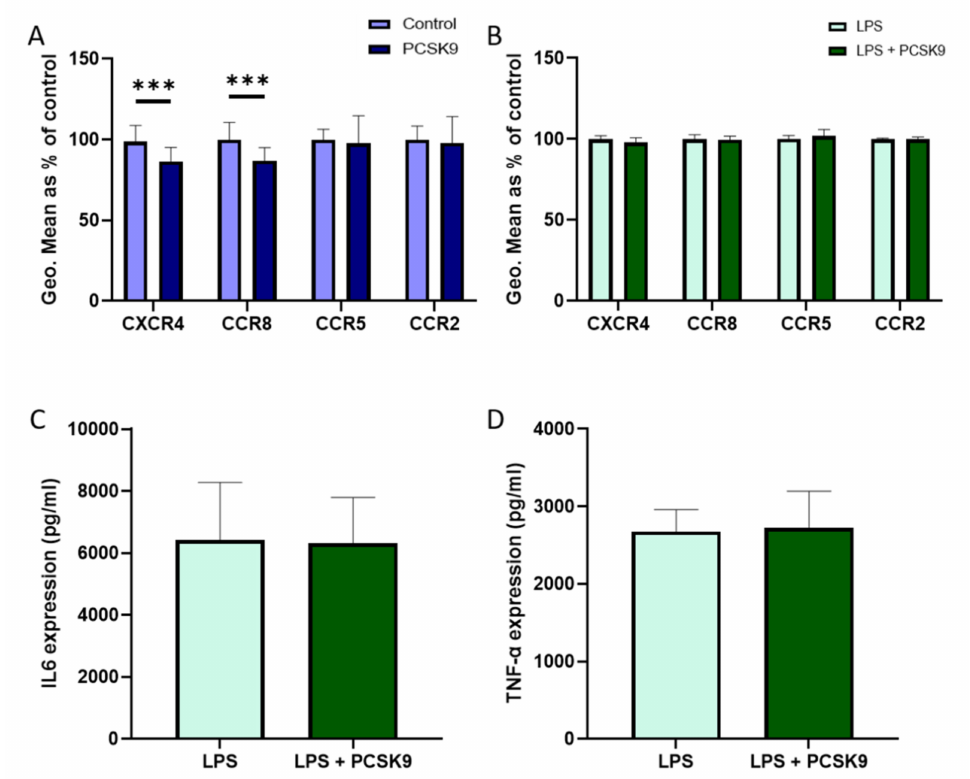
Figure 5. PCSK9 does not change the expression of chemokine receptors and inflammatory cytokines in mouse bone- marrow derived macrophages in vitro. The expression of chemokine receptors CXCR4, CCR8, CCR5, and CCR2 were measured using flow cytometry and represented using geometric mean (Geo.Mean) in mouse bone-marrow derived macrophages ( n = 3–4 replicates) with and without PCSK9 ( A ) and stimulated with LPS ( B ). Inflammatory cytokines IL6 ( C ) and TNF- α ( D ) expression measured in the supernatant of the cell culture with and without PCSK9 in an inflammatory environment ( n = 3–4 replicates). Bar graphs are representation of mean ± SEM. *** p < 0.001. 2-way ANOVA was used for ( A , B ), and Mann–Whitney test was used for ( C , D ) to calculate the statistical